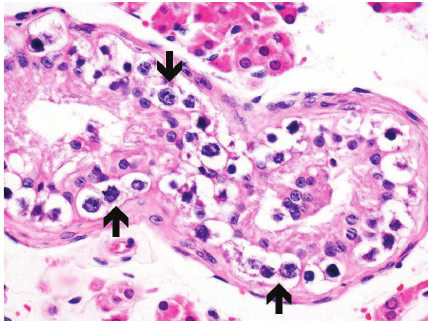
Figure 4: A large number of germ cells (arrows) in dysplastic tubules. A clear halo is seen around them (H&E,